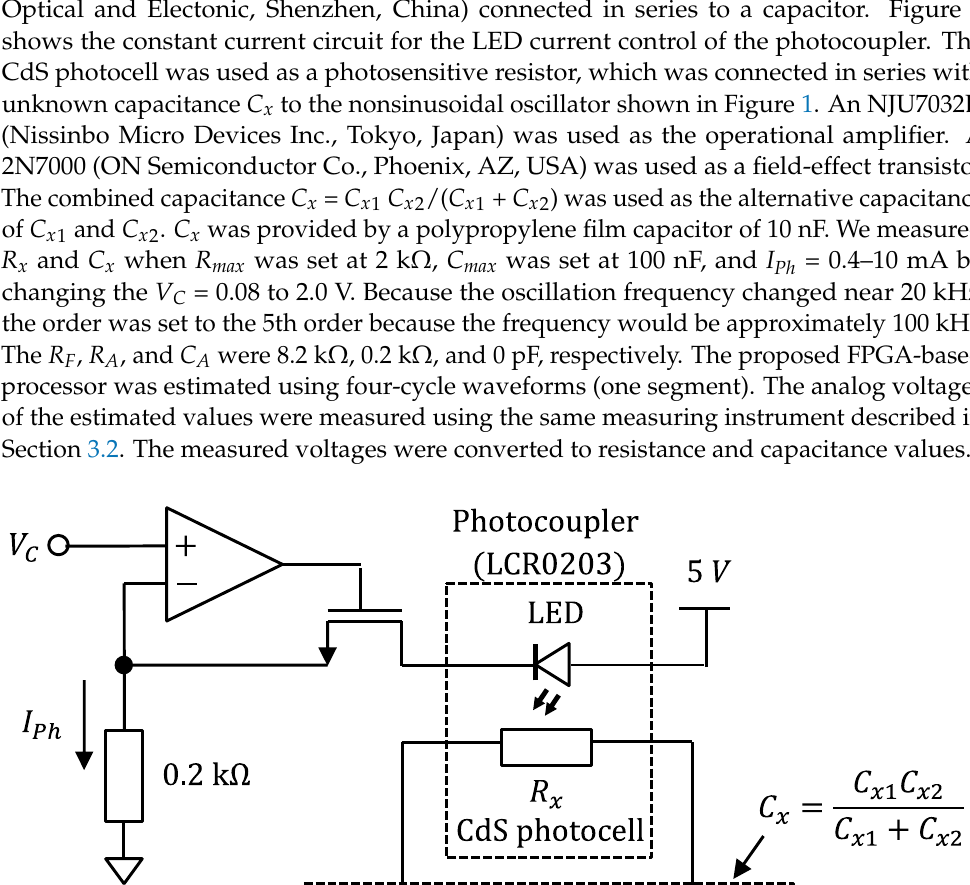
Table 3. Usage of the FPGA resources of the proposed processor in the target FPGA (Z-7020). FPGA Resources